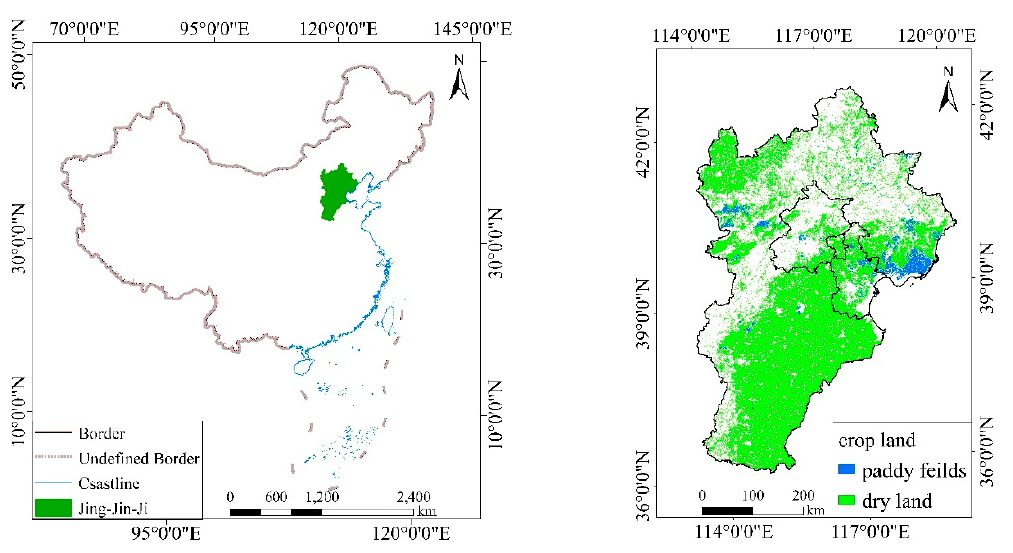
Figure 1. Study area and the crop land distribution.